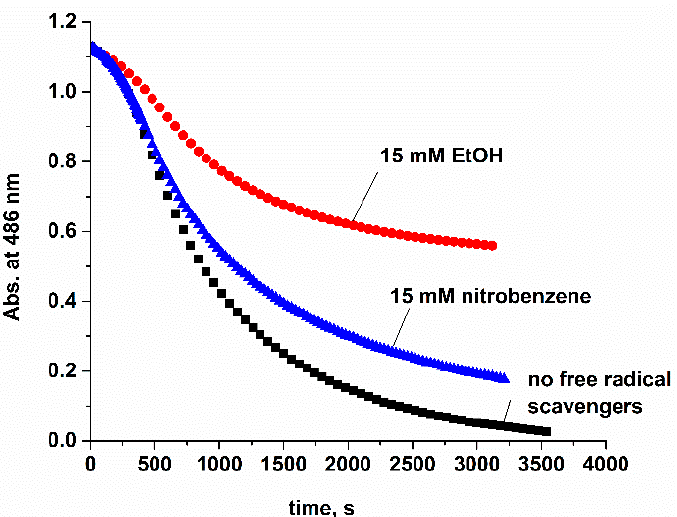
Figure 7. Time-course curves for Orange II (5.5·10 − 5 M) destruction via the mixture of H 2 OCbl (1.0·10 − 6 M) with HSO 5 − (5.0·10 − 4 M) at pH 7.4, 25.0 °C in the absence or in the presence of ethanol (1.5·10 − 2 M) or nitrobenzene (1.5·10 − 2 M).